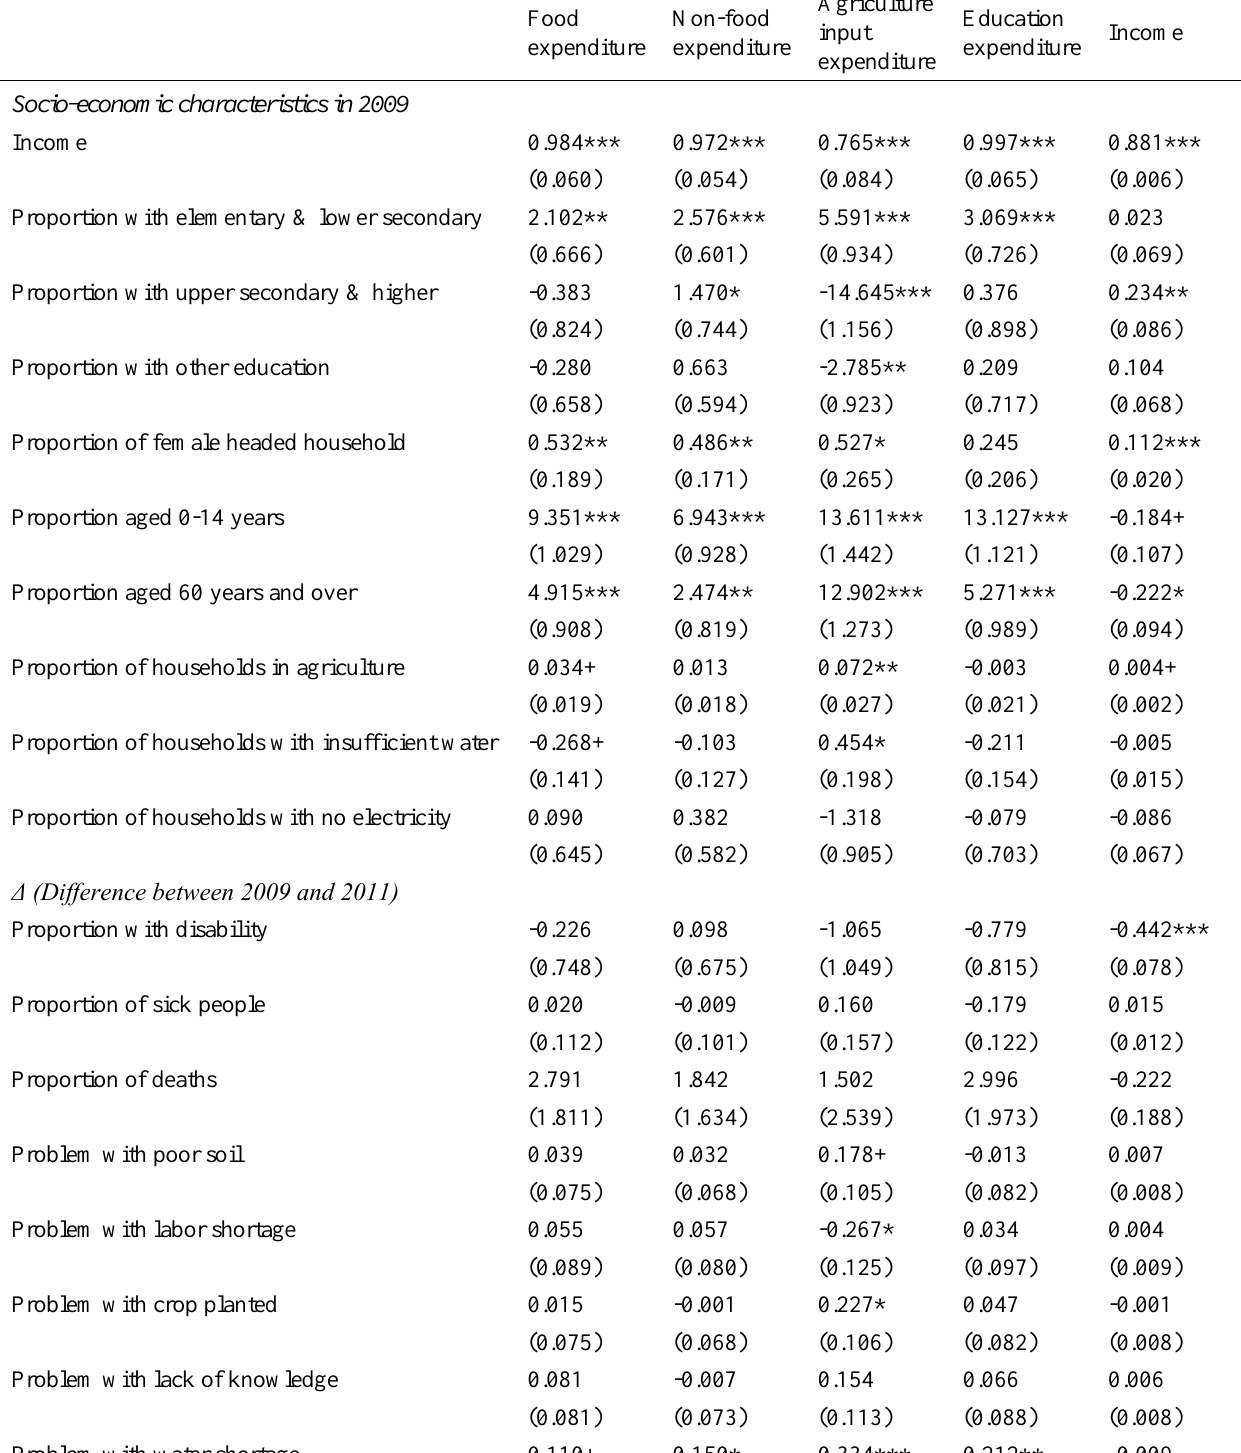
Table A1.2. Difference-in-difference estimates of community welfare (standard errors in parentheses): high education